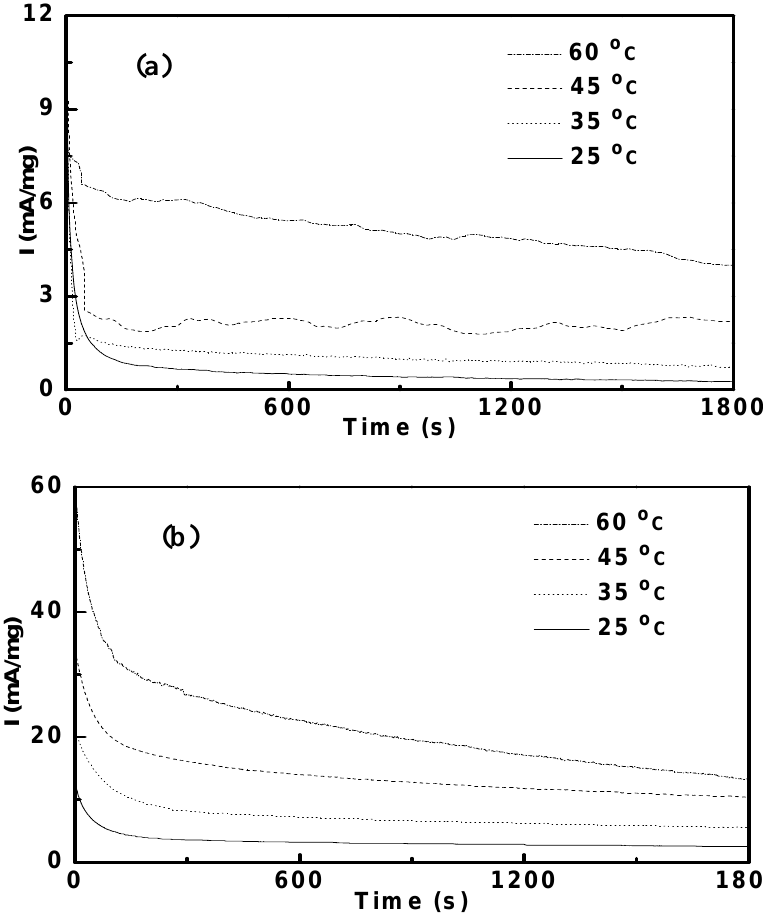
Figure 3. Chronoamperometry performed for methanol electro-oxidation on Pt at different temperatures. The applied potentials are (a) 0.4 V and (b) 0.5